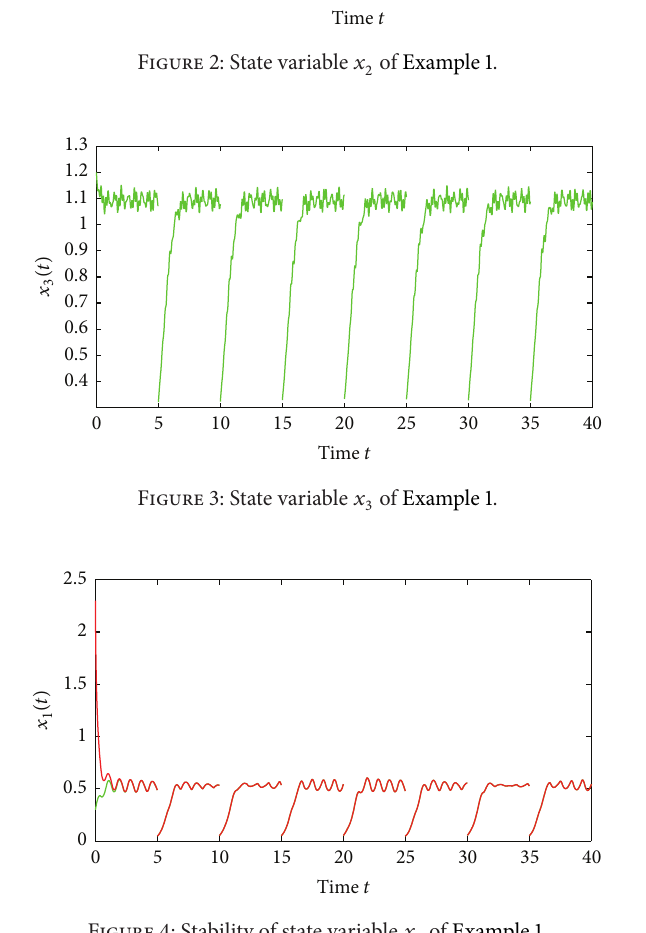
Figure 4: Stability of state variable 𝑥 1 of Example 1.